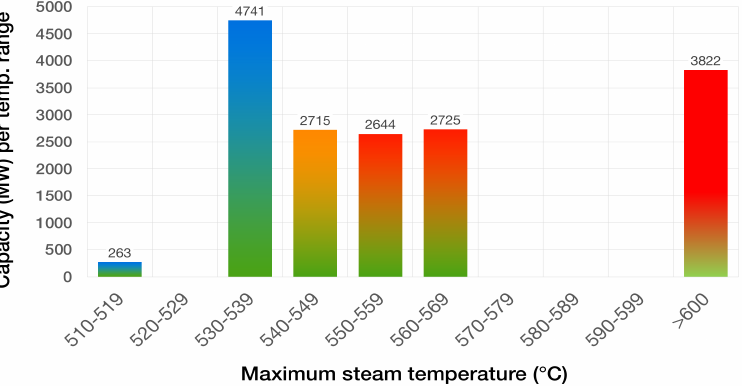
Figure 4. Maximum steam temperature of modern (<20 y) large (>50 MWe) Polish coal